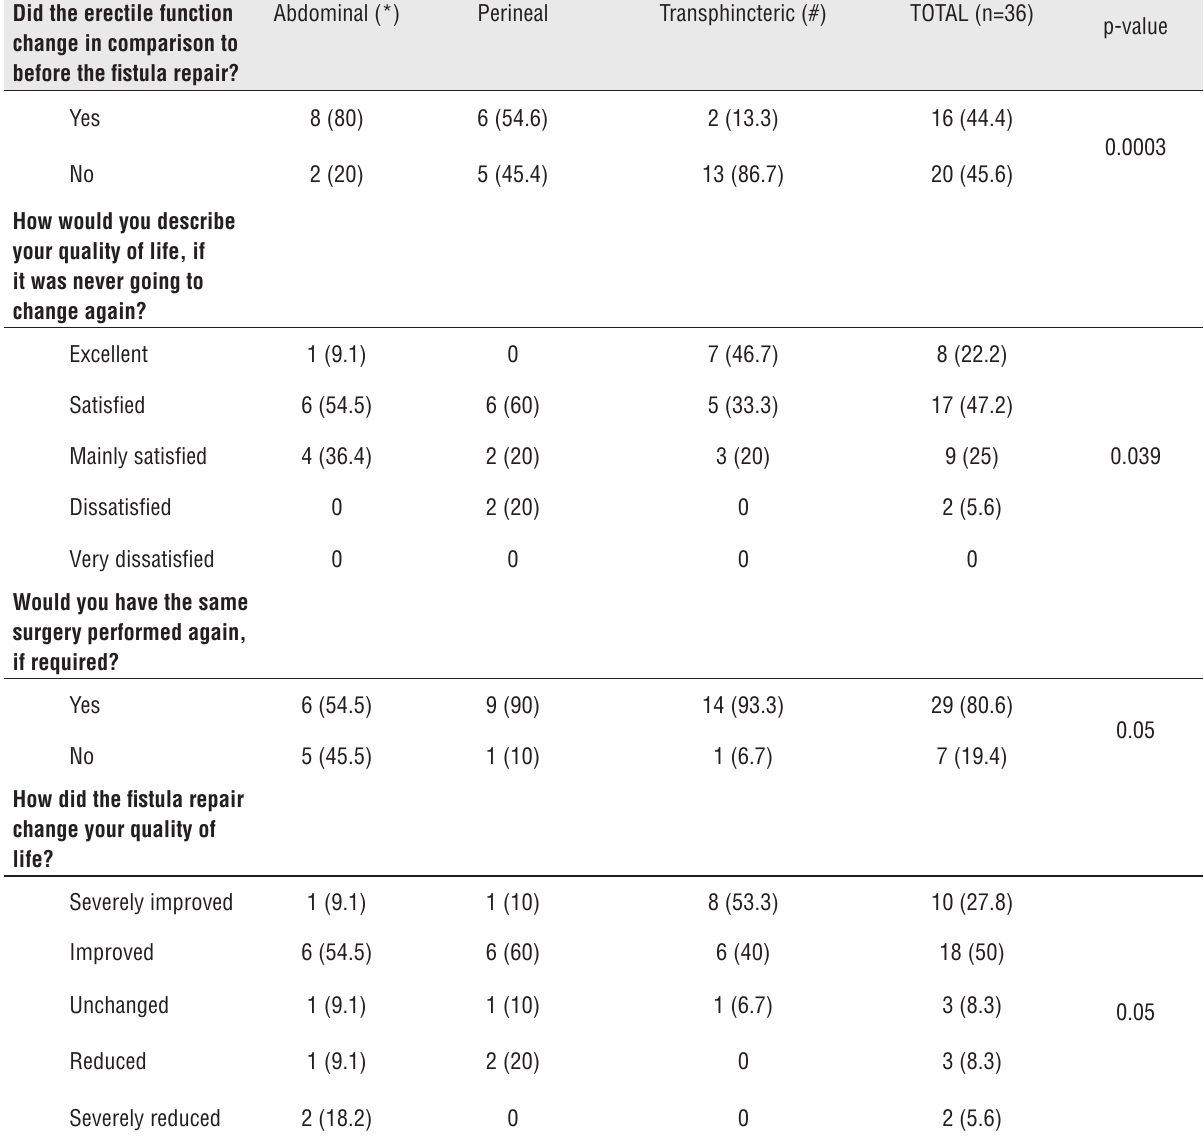
Table 3 - Association between the surgical approaches and specific answers to questions related to HRQoL issues. Question Grouped surgical approaches Did the erectile